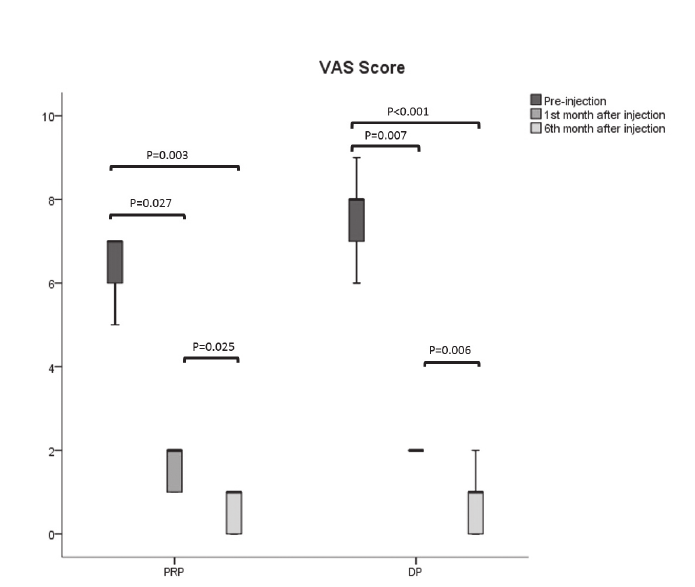
FIGURE 1. The box plots showing the initial and follow-up Visual Analogue Scale (VAS) scores of dextrose prolotherapy (DP) and platelet-rich plasma (PRP)